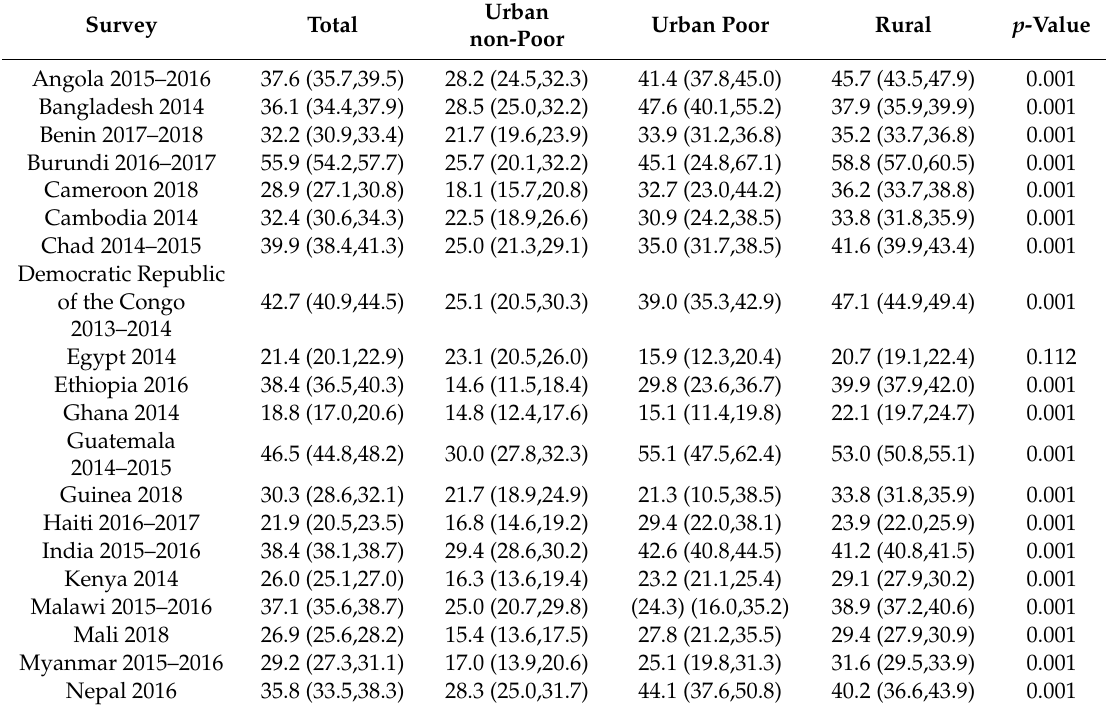
Figure 1. Distribution of the urban poverty cluster variables for the countries in the analysis. Table 1. Surveys used in the analysis with sample sizes and population size. Table 2. Percentage and 95% CI of children under age 5 that are stunted with crosstabulation by urban poverty cluster